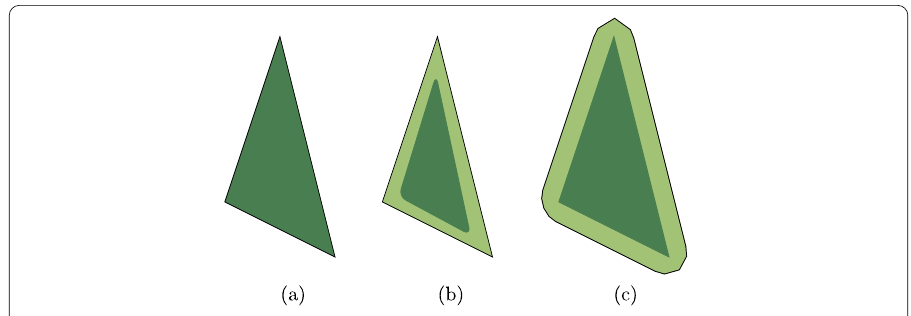
Figure 3 The effect of Erosion ( b ) and Dilation ( c ) applied on an object ( a ) with a ball as structuring element B . According to [31,